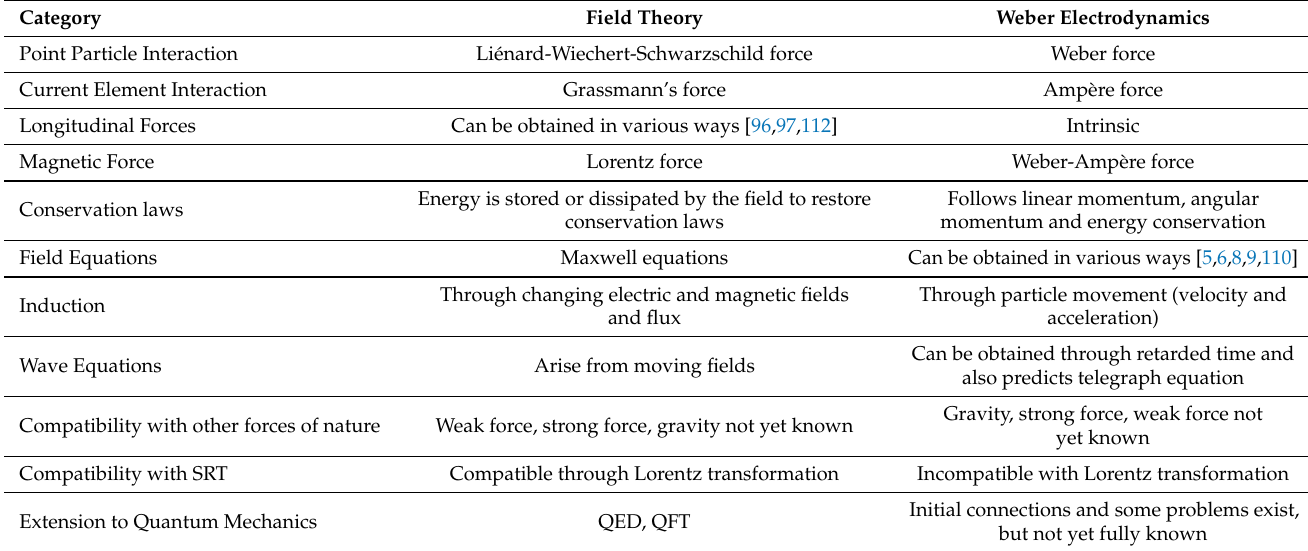
Table 1. A comparison between field and Weber theory in selected